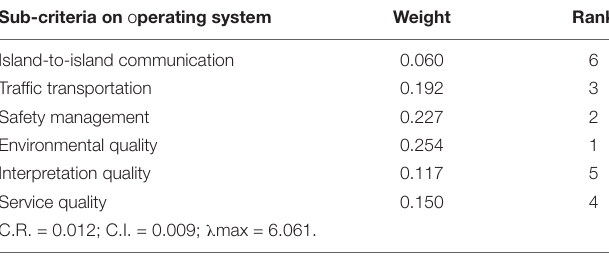
TABLE 7 | Key indicators of operating system.